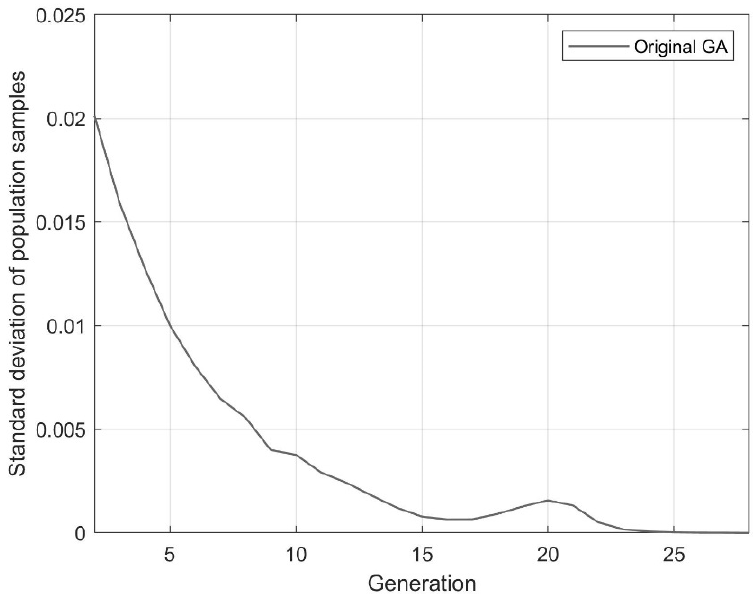
Figure 16. Standard deviation of the objective function of population members for each generation.